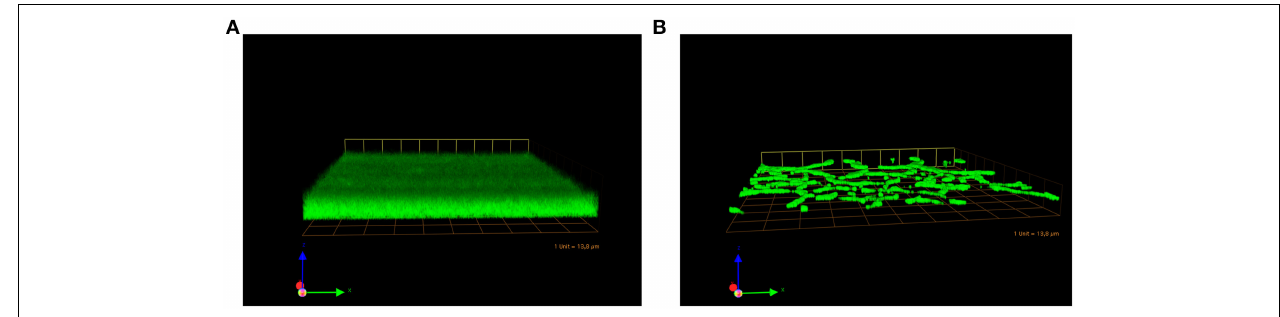
deletion in the pilus backbone gene (Rosini et al., 2006) (B) . Bacteria were grown on glass coverslips under static conditions at 37 ◦ C for 72h, fixed and stained with SYTO-9 prior to confocal analysis (magnification